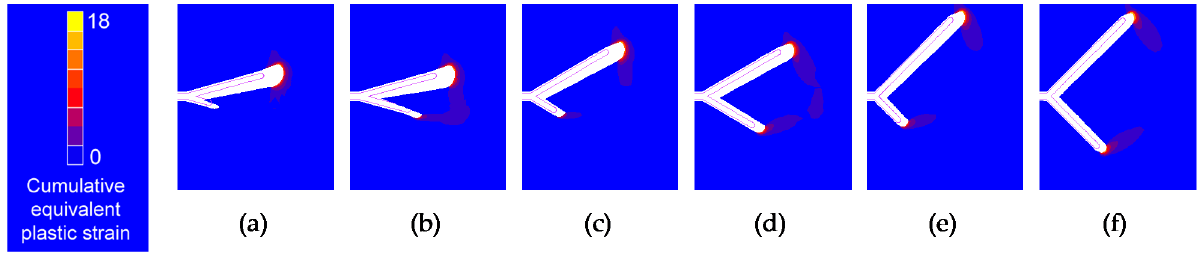
Figure 9. Initial and final crack tip profile and cumulative equivalent plastic strain in the vicinity of bifurcated crack tip with different initial projected branch length and Δ K = 31.25 MPam 1/2 : ( a ) α = 15°, l ’ 2 = 25 µm; ( b ) α = 15°, l ’ 2 = 50 µm; ( c ) α = 30°, l ´ 2 = 25 µm; ( d ) α = 30°, l ´ 2 = 50 µm; ( e ) α = 45°, l ´ 2 = 25 µm; ( f ) α = 45°, l ´ 2 = 50 µm.